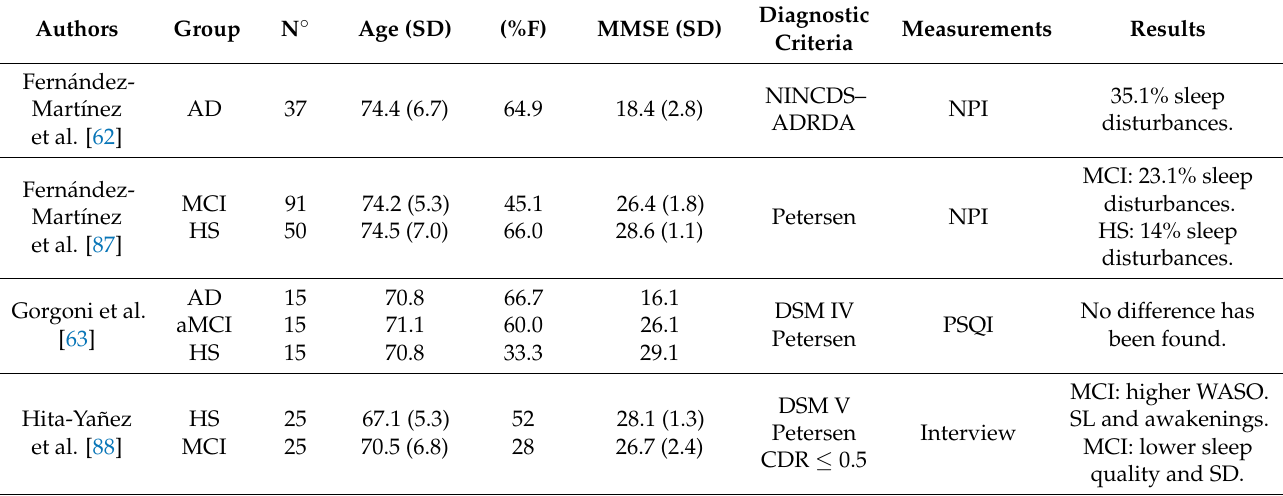
Table 5. Sleep in pathological older age. Summary of all the studies that use subjective